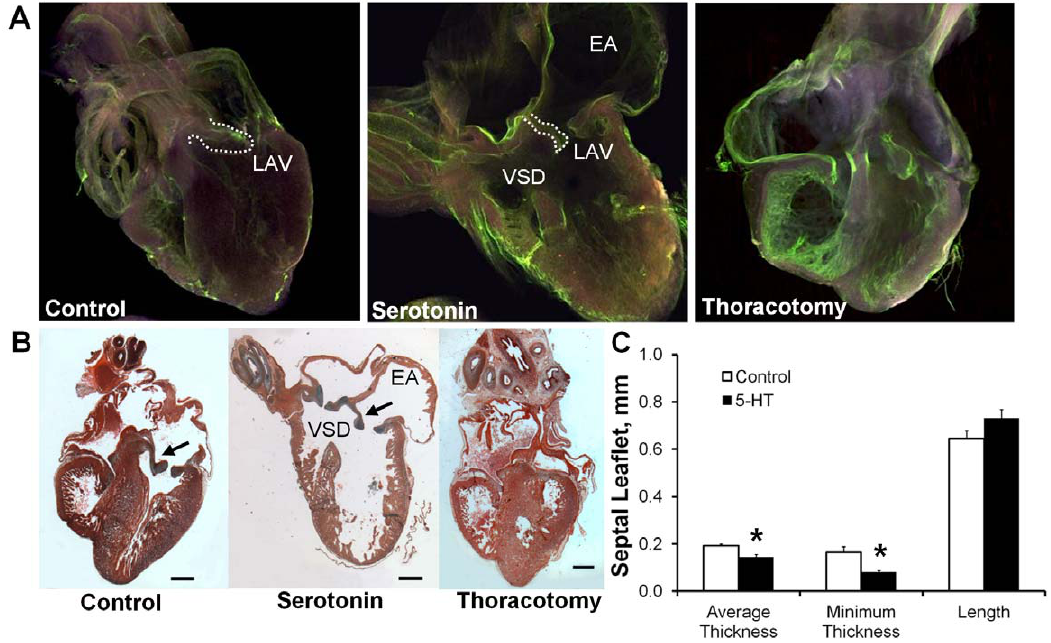
Figure 6. 5-HT administration inovo induces cardiac defects. A ) Representative virtual sections of control, 5-HT treated, and thoracotomy sham control hearts at HH36 via endopainting and confocal microscopy. B ) Representative Movat’s pentachrome stained sections of hearts with the same conditions. Prominent cardiac defects, including enlarged atria (EA) and ventricular septal defect (VSD), were associated with malformed and malfunctioning AV valves (arrows). 25 6 , scale bar=500 m m. C ) Left septal leaflet average thickness and minimum thickness are both statistically thinner in 5-HT treated leaflets than control. mean 6 SEM, n=3–6 hearts per treatment, *p , 0.05, t-test.